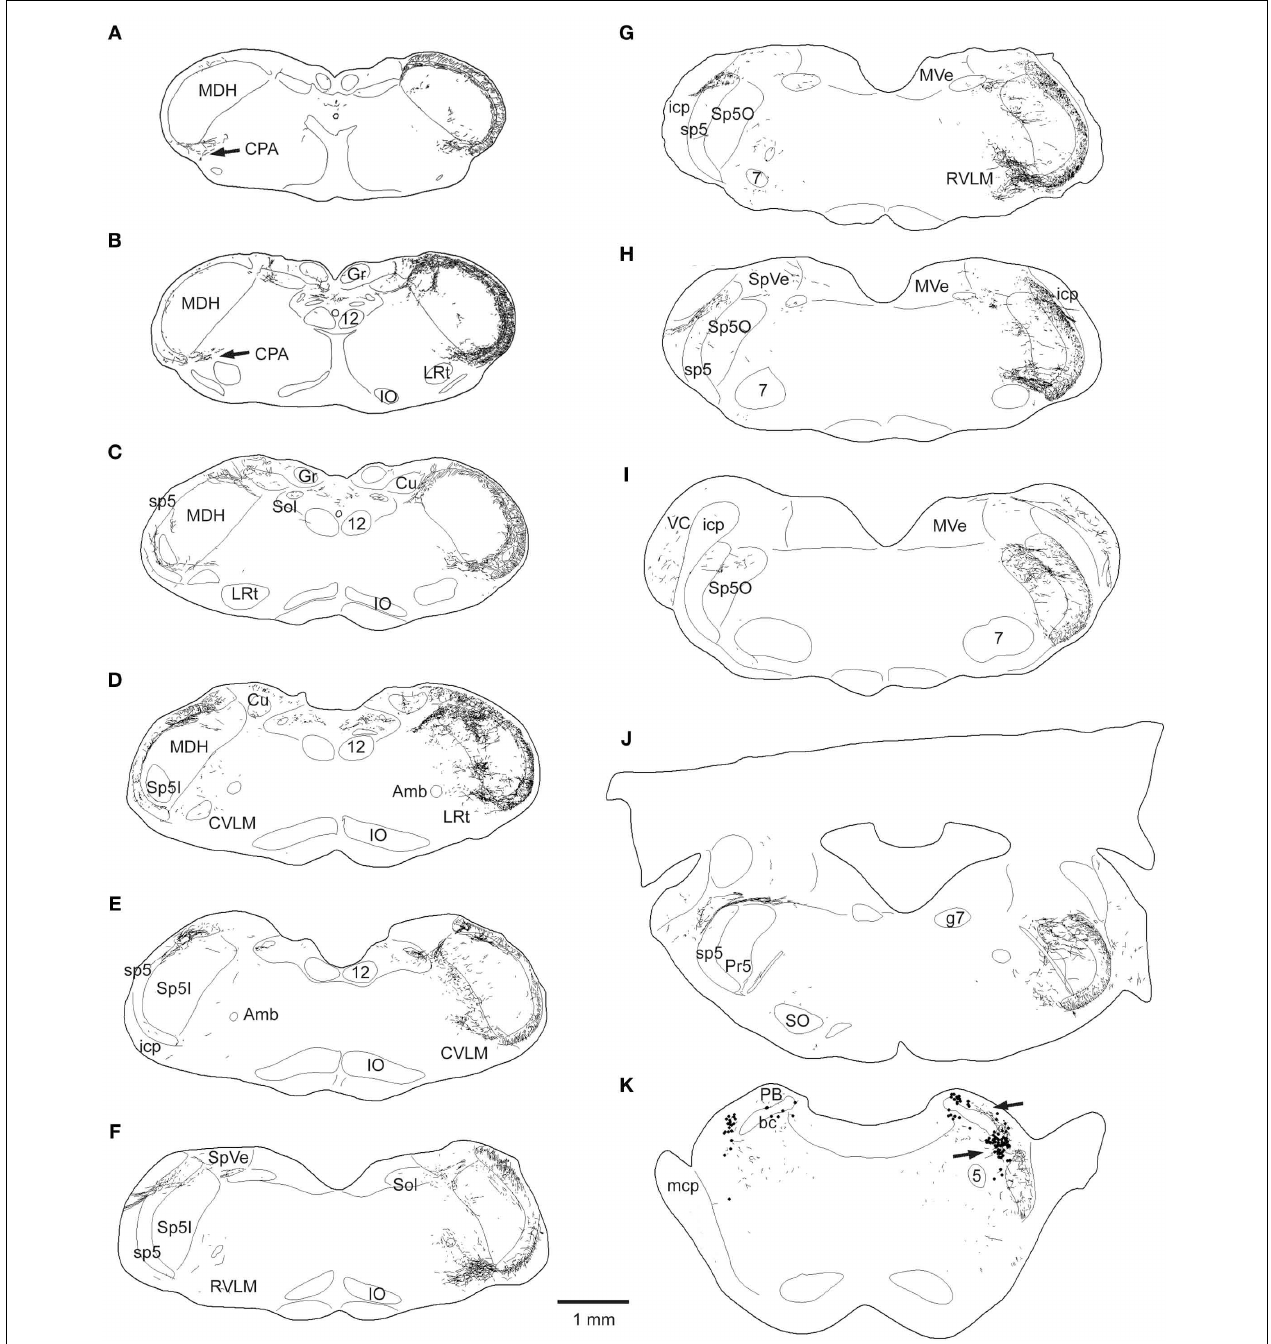
FIGURE 2 | Line drawings showing the loss of CGRP fibers in the brainstem after unilateral trigeminal rhizotomy. The normal distribution of CGRP is seen on the right side of these brainstem sections; note its dense distribution in the spinal trigeminal complex, especially in the medullary dorsal horn (MDH) and subnucleus oralis, as well as the CPA (A,B) , the CVLM (D,E) , peri-ambiguus areas (D–F) , the RVLM (F,G) , and the parabrachial complex (K) . Trigeminal rhizotomy (left side of sections) eliminated almost all fibers in the spinal trigeminal tract and most of the label in the spinal trigeminal nucleus (see text), suggesting its origin in primary afferent fibers with cell bodies in the trigeminal ganglion. Importantly however, CGRP label was particularly diminished in